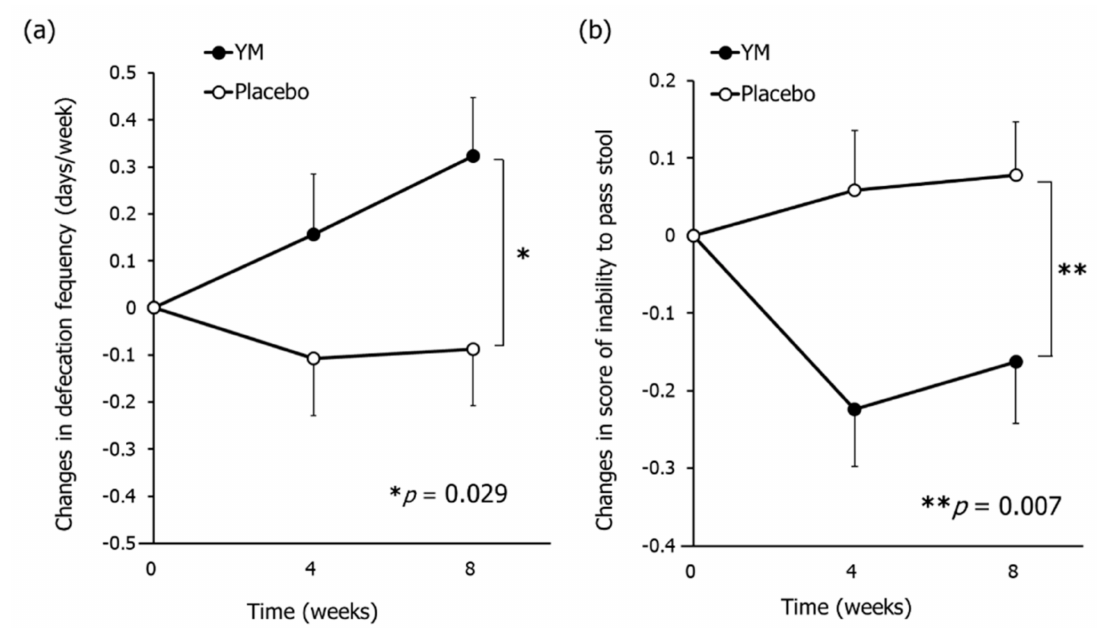
Figure 2. E ff ects of YM intake on constipation symptoms. Changes in defection frequency (days / week) ( a ) and CAS score of inability to pass stool ( b ). The black circles represent the YM group and the white circles represent the placebo group. Data represent the means ± SE. The p -values were measured using repeated-measures ANOVA for the di ff erences between groups without multiple comparison correction. CAS: Constipation assessment scale. Asterisks indicate overall significance between groups across time points (* p < 0.05, ** p <